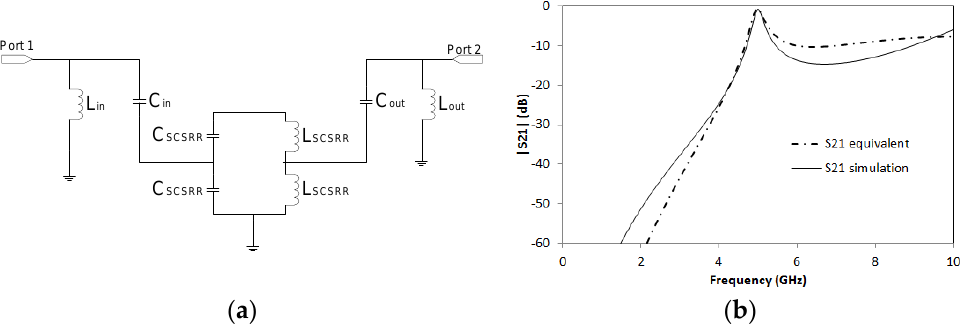
Figure 8. ( a ) Equivalent circuit model 2-layer resonator previously depicted. ( b ) Simulated S21 (solid black line) and simulated S21 for equivalent circuit model (dash-dotted line).